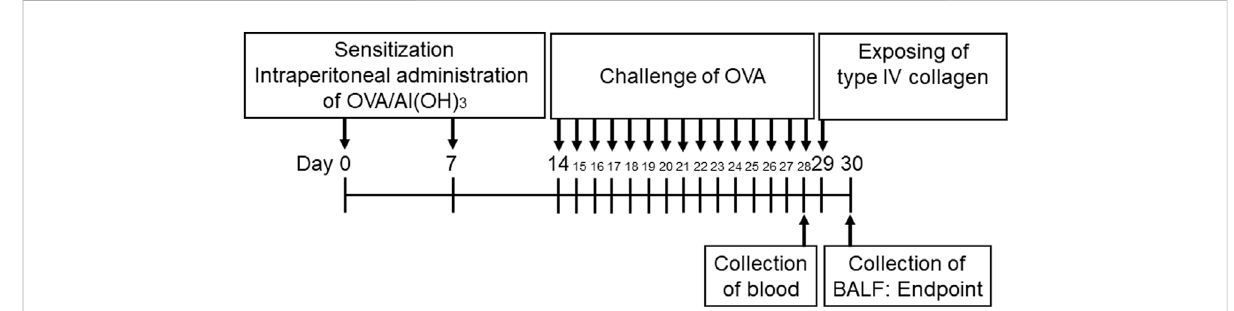
FIGURE 1 Timetableforestablishingovalbumin(OVA)-sensitizedmice.Themiceweresensitized via